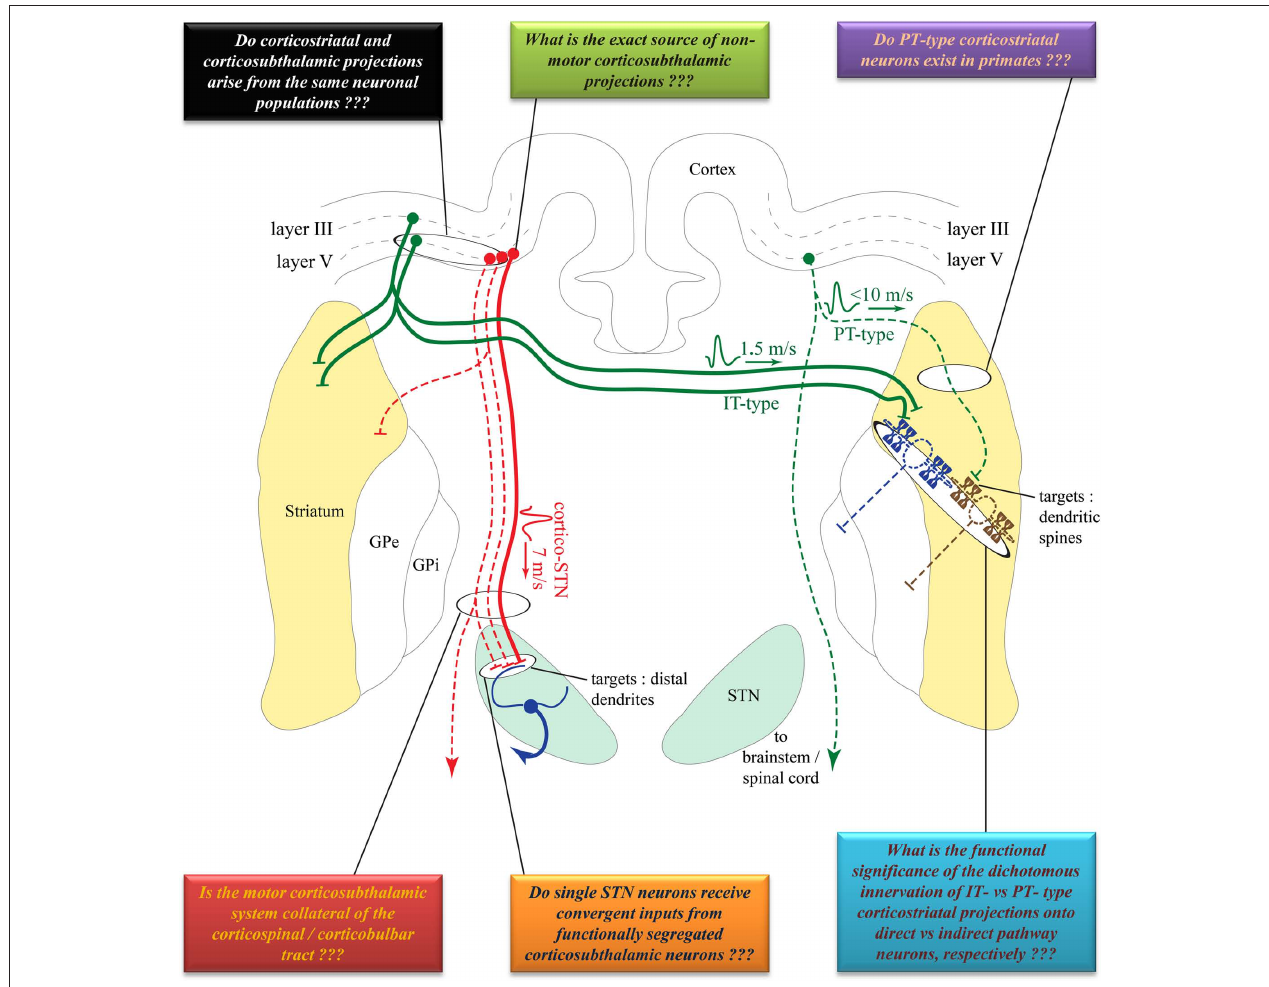
anatomical, synaptic, and functional organization of these two pathways. See text for abbreviations. Anatomical structures are not to scale, but depicted solely for illustrative purposes and are not necessarily in the same coronal plane. Some connections have been purposefully omitted to